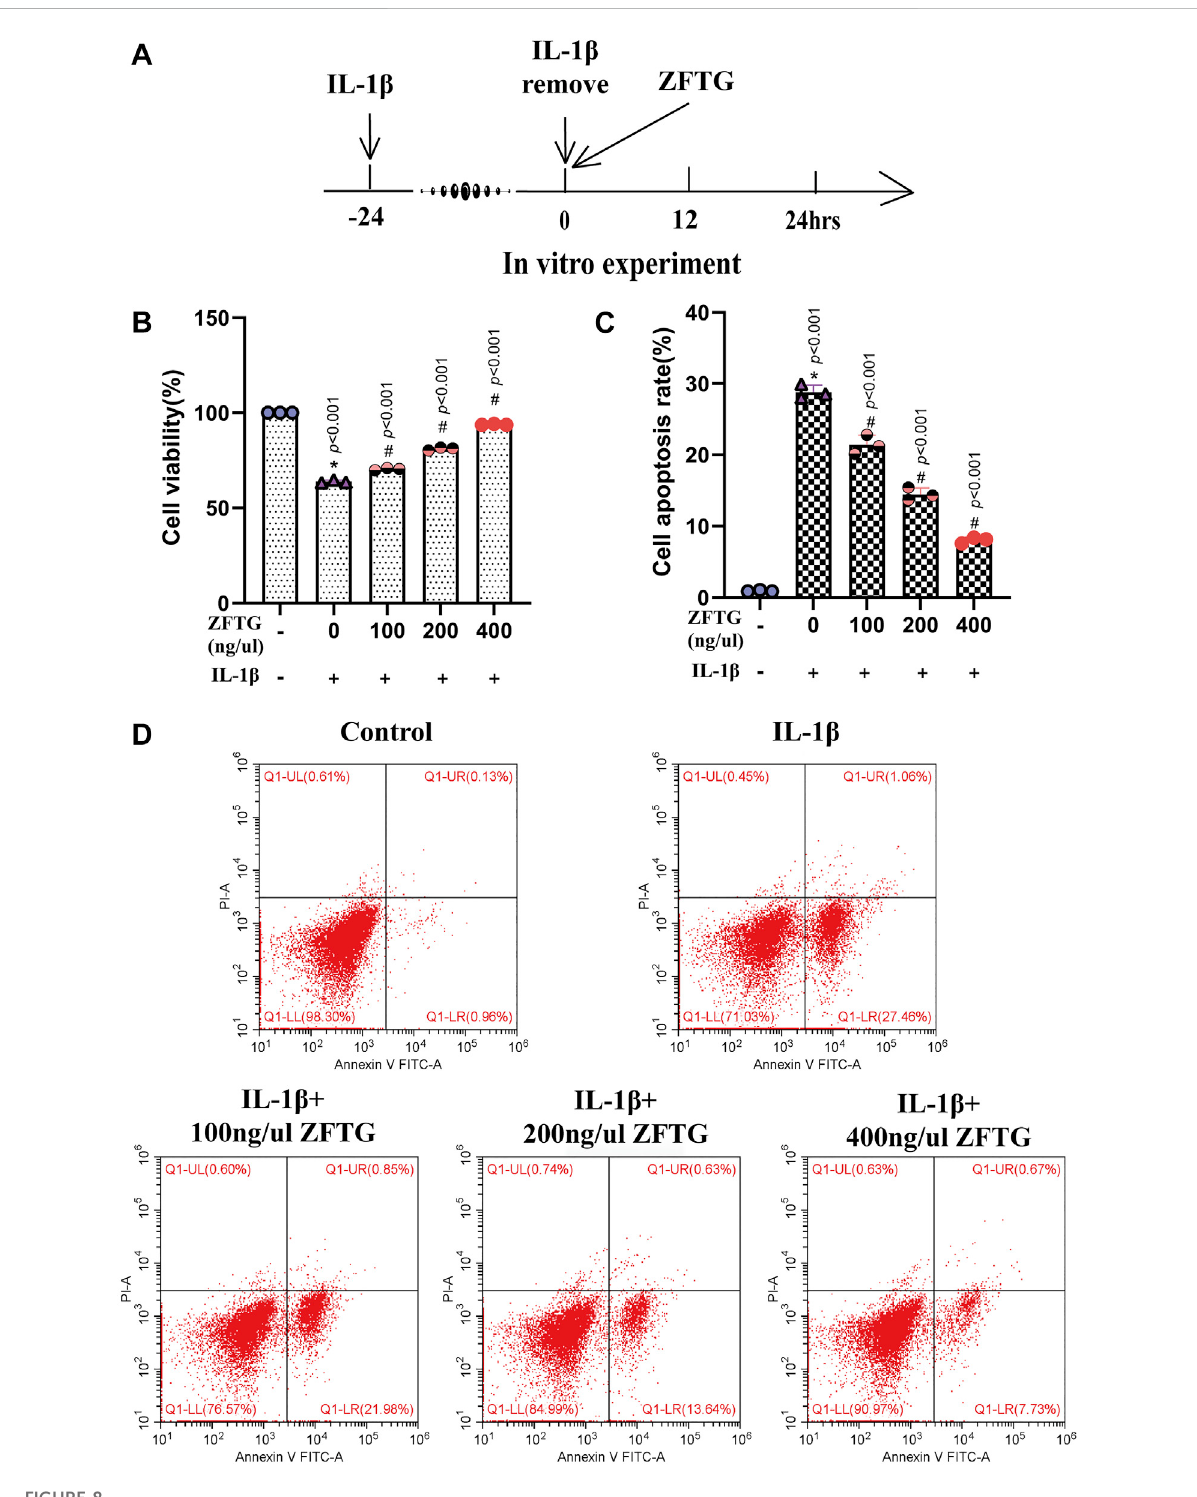
FIGURE 8 ZFTG improves in fl ammatory injury of cartilage cells. (A) Experiment design for cells. Primary chondrocytes were stimulated with IL-1 β (10 ng/ ml)for24 h s(M IL-1 β )beforeremovingIL-1 β andaddingZFTG(0,100,200,and400 ng/ μ l)treatmenttoevaluatecellviabilityandapoptosisrate.Cells were harvested 24 h after ZFTG treatment. (B) Cell viability after ZFTG intervention at various concentrations based on the control group (100%). (C) Cell apoptosis rate after ZFTG intervention at various concentrations. (D) Apoptosis of chondrocytes among fi ve groups by fl ow cytometry. One-way analysis of variance was used for comparing the cell viabilities and apoptosis rates. The data are presented as the mean ± SD. * p < 0.05, vs. the control group; # p < 0.05, vs. IL-1 β group. Speci fi c p -values for each pair of comparison are reported. The control group: ZFTG − /IL-1 β − ; the IL-1 β group: ZFTG − /IL-1 β +